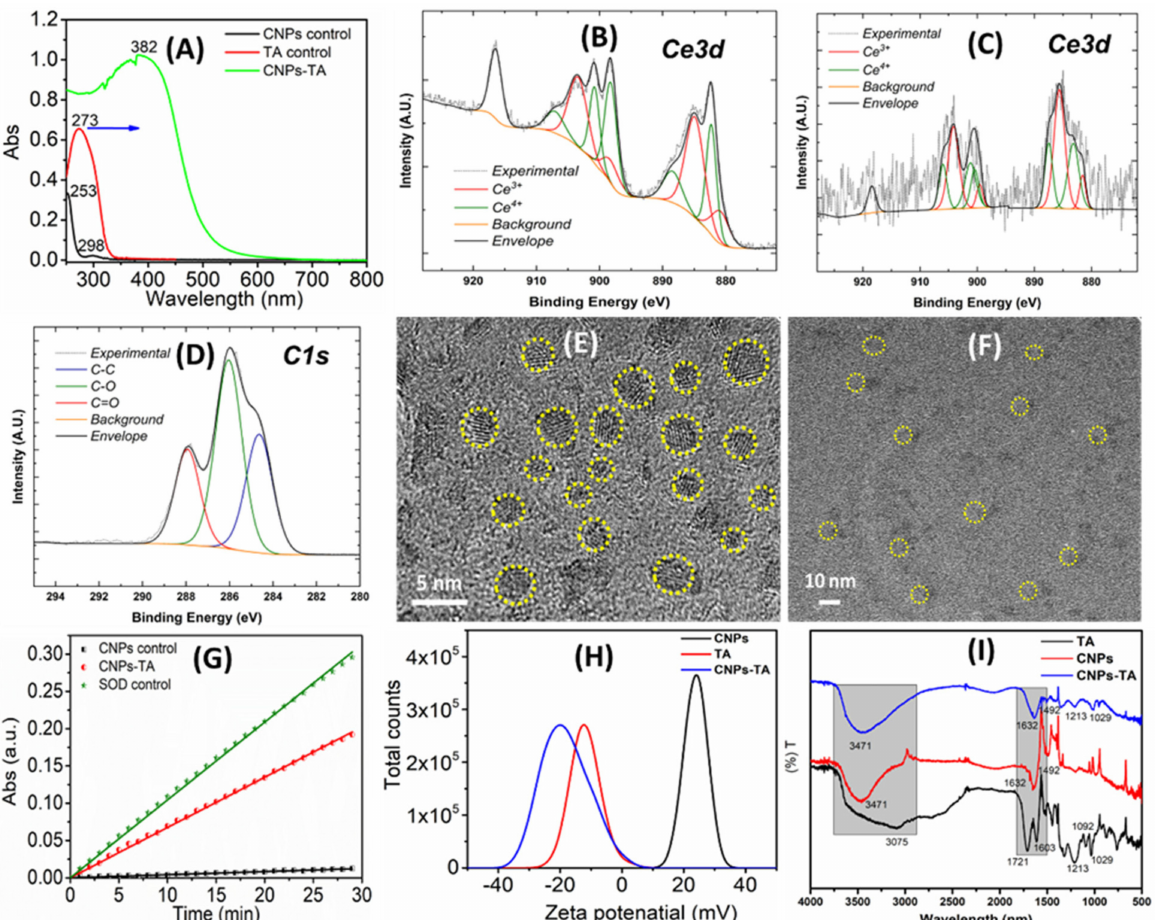
Figure 2. Shows various materials characterization techniques subjected to tannic acid (TA) molecules conjugated with cerium oxide nanoparticles (CNPs) by the bioconjugation process at room temper- ature. ( A ) UV − Vis spectrum of control CNPs (peaks at 253 and 298 nm), TA (peak at 273 nm), and CNPs − TA (peak at 382 nm). ( B – D ) X − ray photoelectron spectroscopy (XPS) spectrum of con- trol CNPs, TA, and CNPs − TA. ( E , F ) High-resolution transmission electron microscopy (HR − TEM) images of control CNPs and CNPs − TA. ( G ) Superoxide dismutase (SOD) activity of CNPs − TA compared with control SOD and CNPs. ( H ) The zeta potential of pure and conjugated samples. The zeta potential of control CNPs showed 23 ± 2 mV, which changed to − 19 ± 2 mV after conjugation of the TA molecule. ( I ) FTIR spectrum of TA, CNPs and CNP-TA